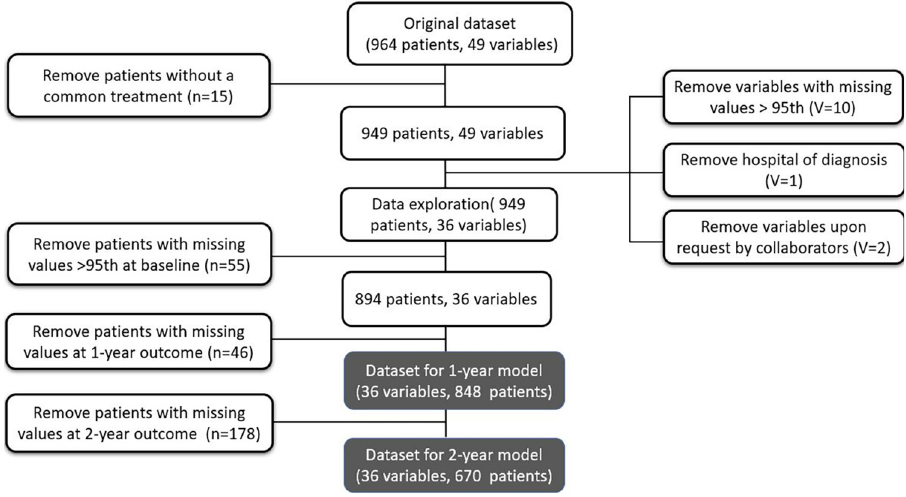
Fig 1. A flow diagram of the study population, indicating how the datasets for the 1-year model and the 2-year model were retrieved. Each model’s variables and data are shown in gray.